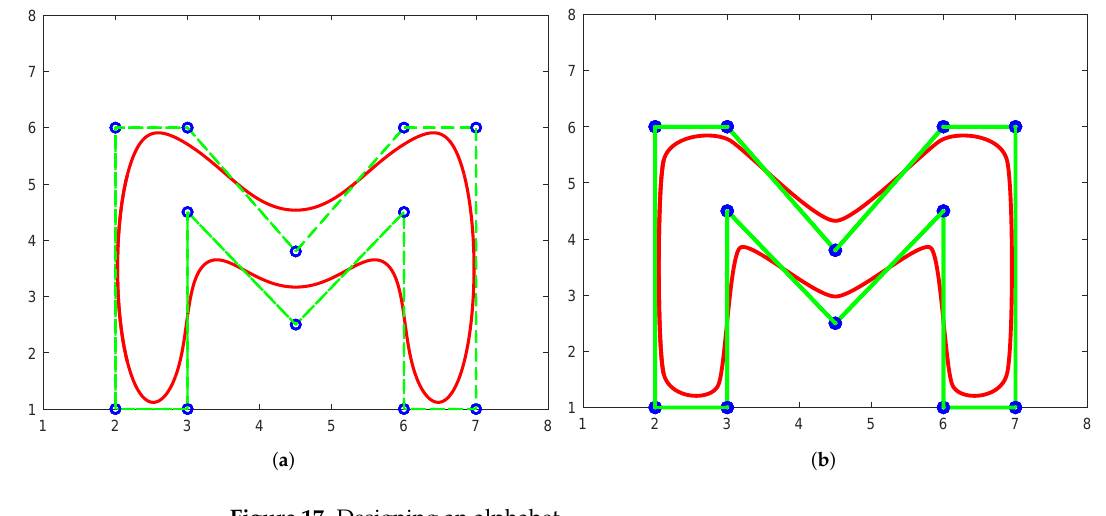
Figure 17. Designing an alphabet.